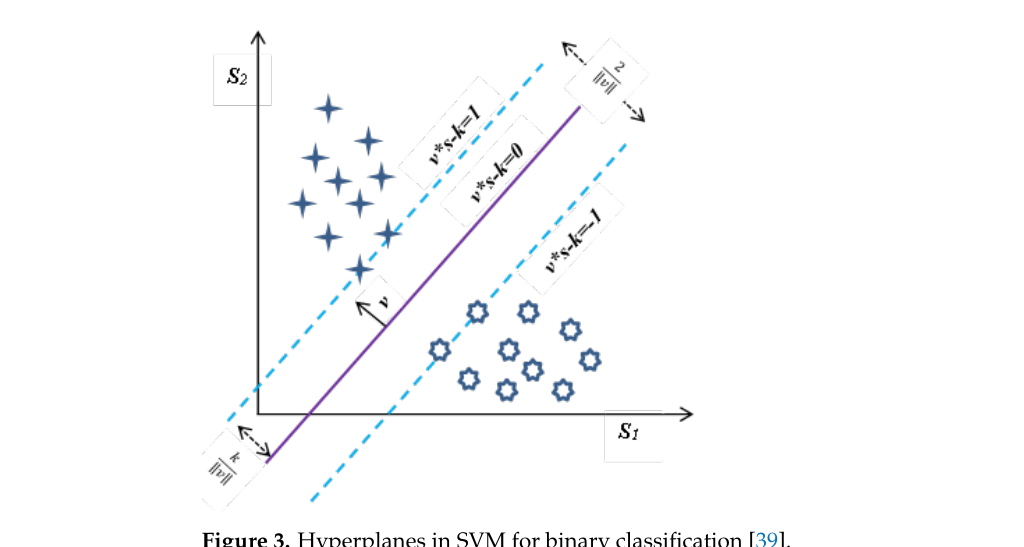
Figure 3. Hyperplanes in SVM for binary classification [39].